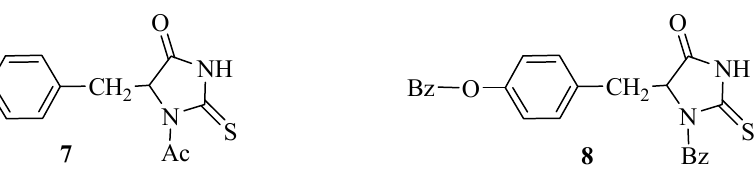
Figure 1. Reaction byproducts 7 and 8